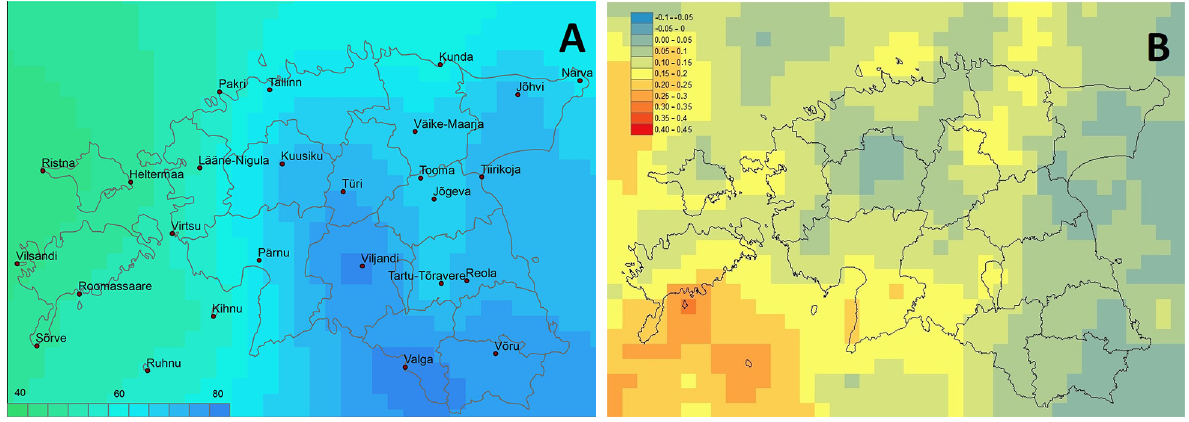
Fig. 2. Average precipitation (mm) of July for the reference period 1971–2000 ( A ) and changes from the KAUR model ensemble according to the scenario RCP8.5 for the period 2071–2100 ( B ); –0.1 refers to 10% reduction in the precipitation compared to the reference